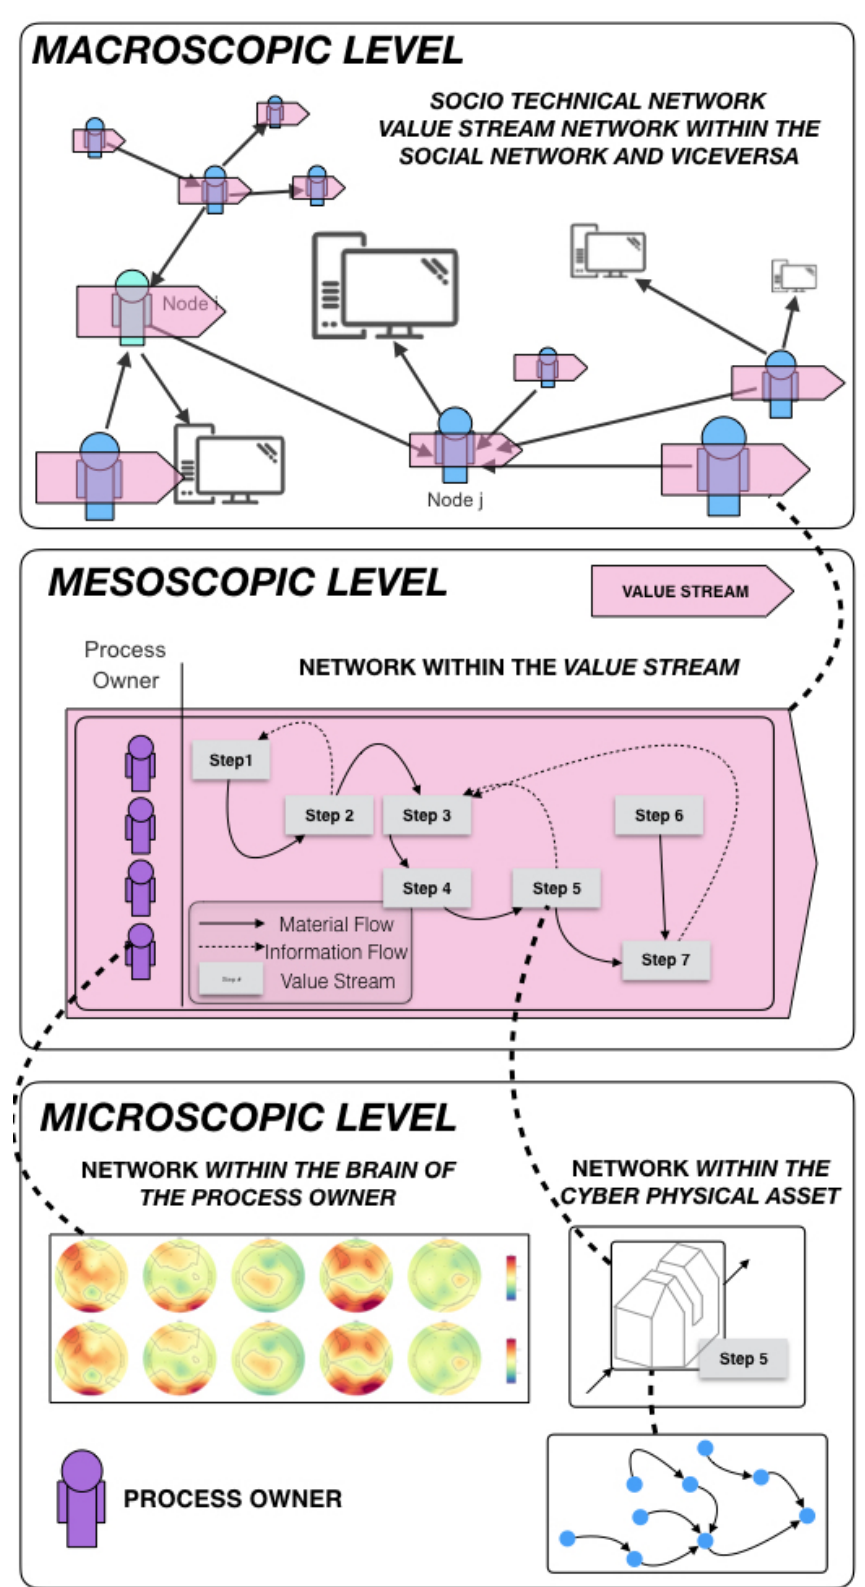
Figure 1. Macroscopic, mesoscopic, and microscopic levels of organizational sociotechnical complexity.